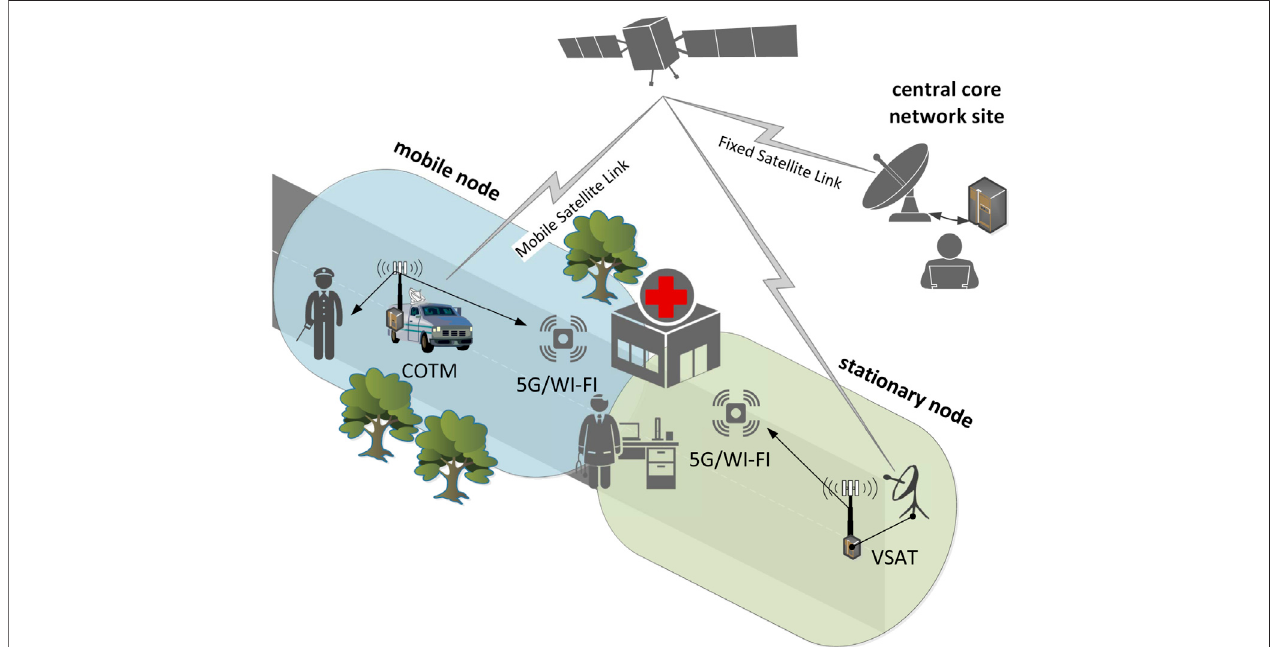
FIGURE 1 | Remote hospital